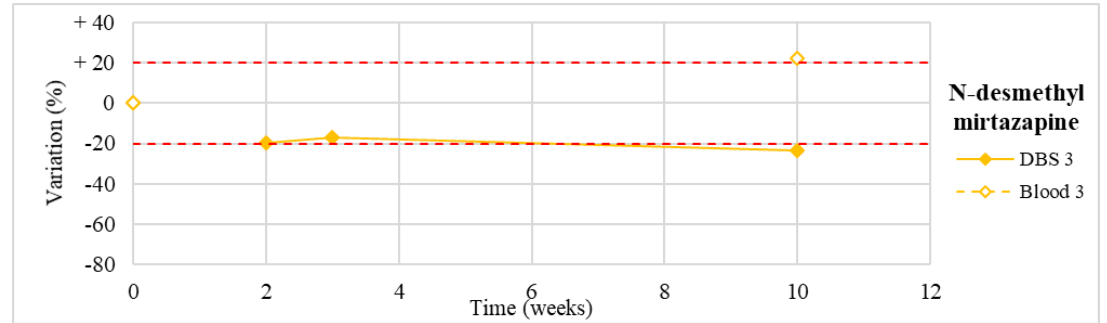
Figure 4. Long-term stability of mirtazapine ( n = 1) in DBSs stored at room temperature and in blood stored at −20 °C (T0–T4).